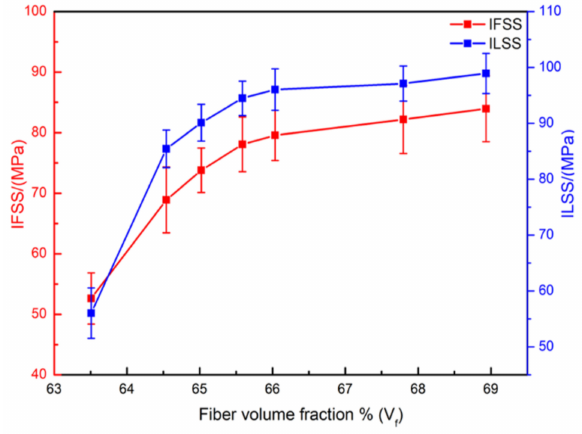
Figure 12. Changes in the IFSS and ILSS of the composite specimens as fiber volume